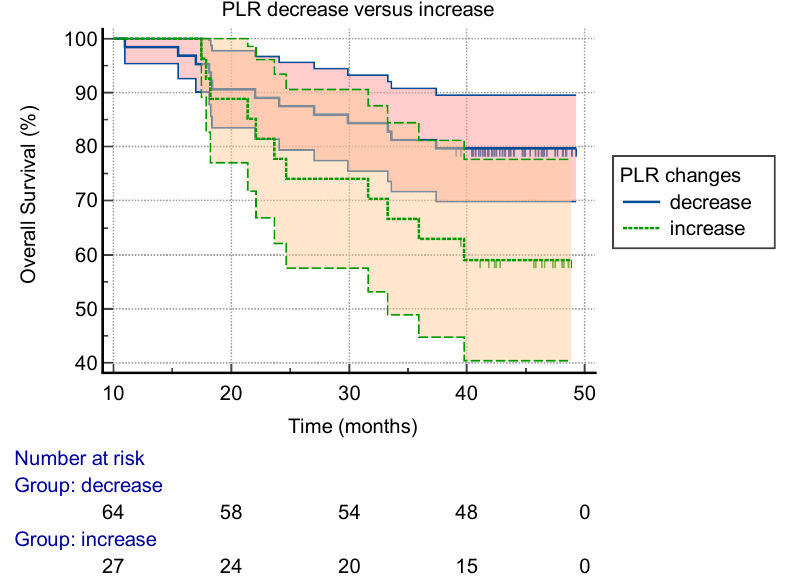
Figure 2. Kaplan–Meier survival plots according to the changes in PLR before and 6 months after Figure 2. Kaplan – Meier survival plots according to the changes in PLR before and 6 months after operation. PLR: platelet-to-lymphocyte operation. PLR: platelet-to-lymphocyte ratio.